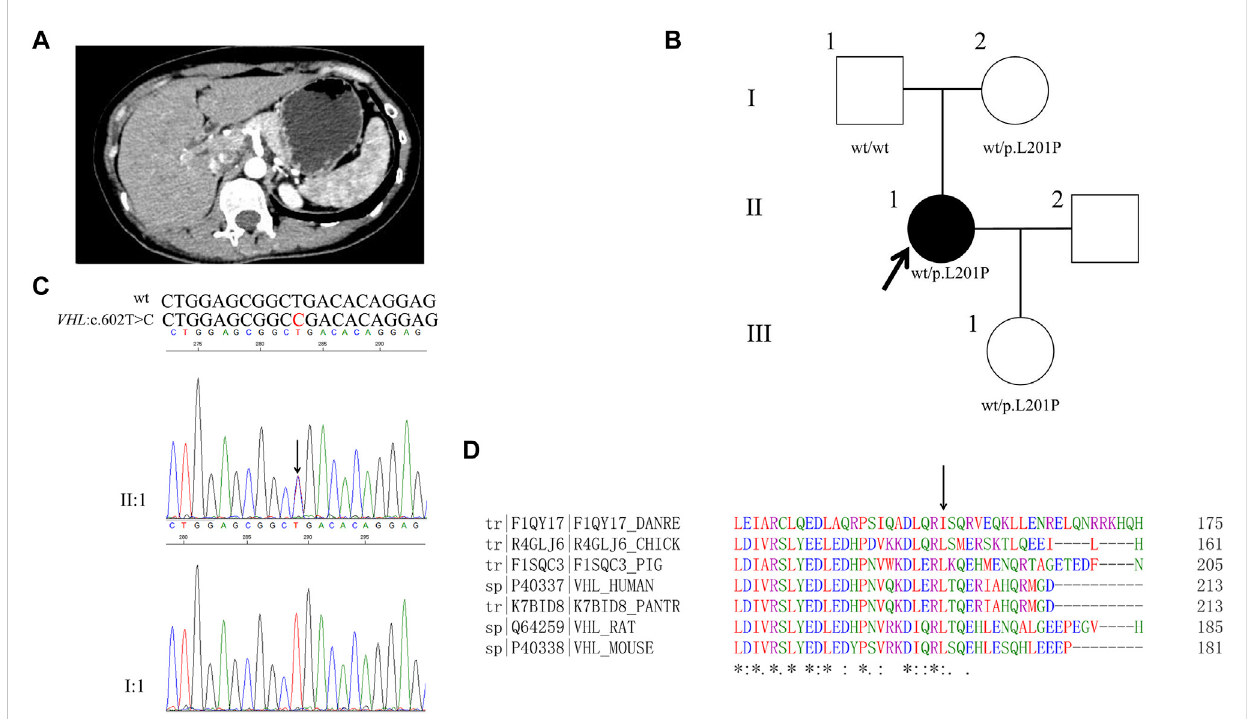
FIGURE 3 Clinical and genetic characteristics of Proband 3. (A) Postoperative contrast-enhanced CT scan of adrenal in a 36-year-old female patient with PPGL. (B) Pedigree of the Proband 3 family with PPGL. Squares and circles indicate males and females, respectively; Roman numerals indicate generations; and Arabic numerals indicate individual family members. Each member ’ s VHL genotype are shown below the squares and circles. Wt, wild type.L,lysine;P,proline. (C) DNAsequencingdataofanunaffectedmale(I:1)andtheProband3(II:1)withtheheterozygousvariantof VHL c.602T > C. wt,wildtype. (D) MultipleproteinsequencealignmentofsevenspeciesforVHLp.L201(arrow).Anasterisk(*)indicatespositionsthatare100%conserved in the alignment, and a colon (:) indicates conservation between groups of strongly similar properties, whilst a period (.) indicates conservation between groups of weakly similar properties. The residues in the alignment are coloured to indicate their physicochemical properties. Red indicates small and hydrophobic amino acids, blue indicates acidic residues, magenta indicates basic and green denotes hydroxyl/sulfhydryl/amine